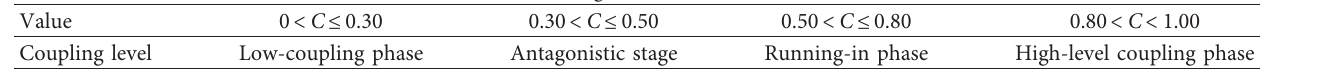
Table 3: Evaluation grade of the C of AT and TD.